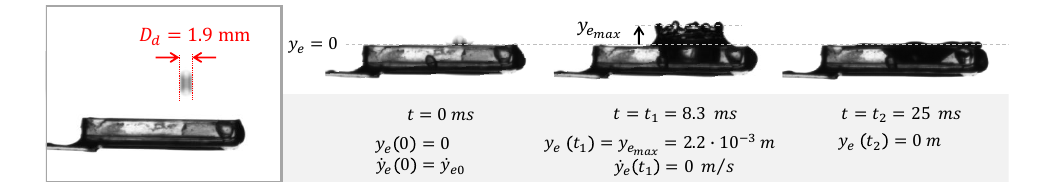
Figure 15. Comparison between the experimental (red) and simulated (blue) harvester voltage in the time ( a ) and frequency ( b ) domain for a drop impacting on a dry spoon.